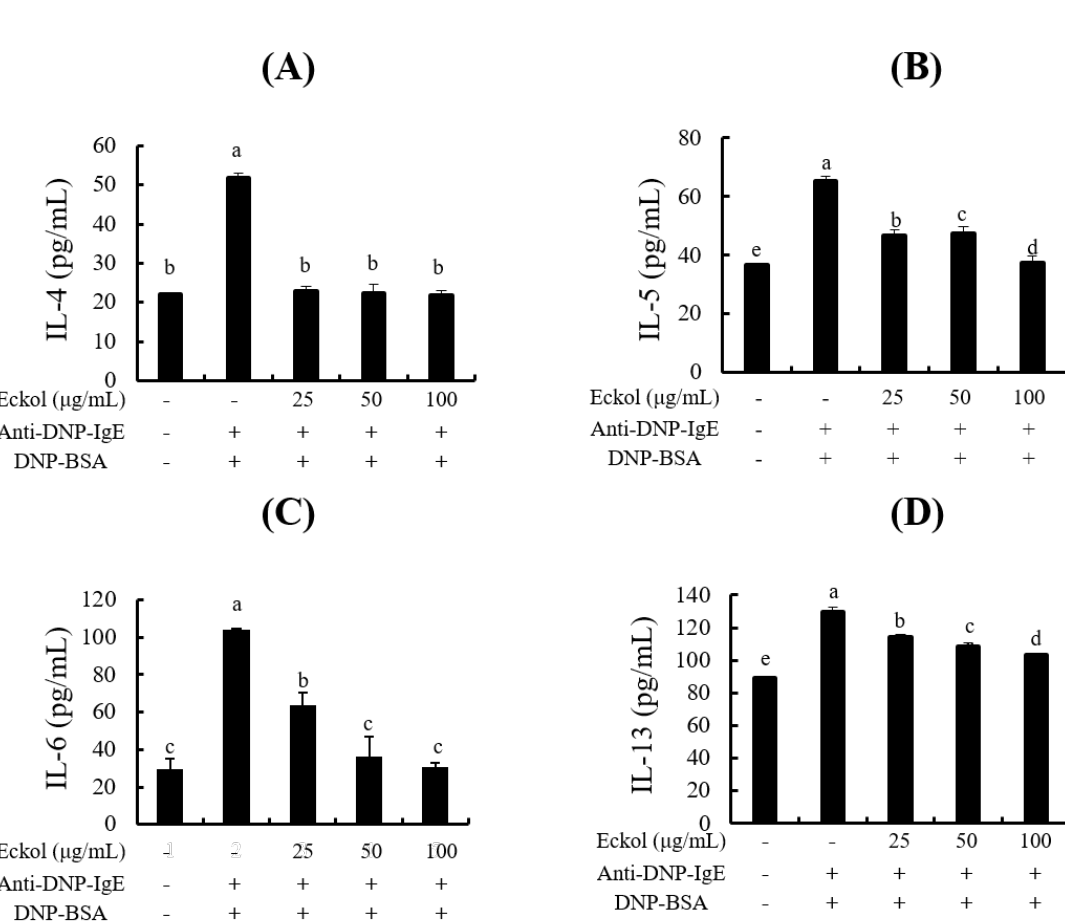
Figure 3. E ff ects of eckol on cytokine production in IgE / BSA-stimulated BMCMC. ( A ) IL-4, ( B ) IL-5, ( C ) IL-6 and ( D ) IL-13 production. Data are expressed as means ± SD ( n = 3) of three individual experiments. Di ff erences in mean value among groups were assessed by one-way analysis of variance followed by Duncan’s test using PASW statistics 21.0. A value of p < 0.05 was considered statistically significant.